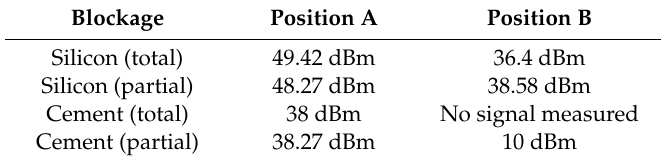
Table 2. Signal measured in dBm depending on the type of blockage and the position of the receiver.